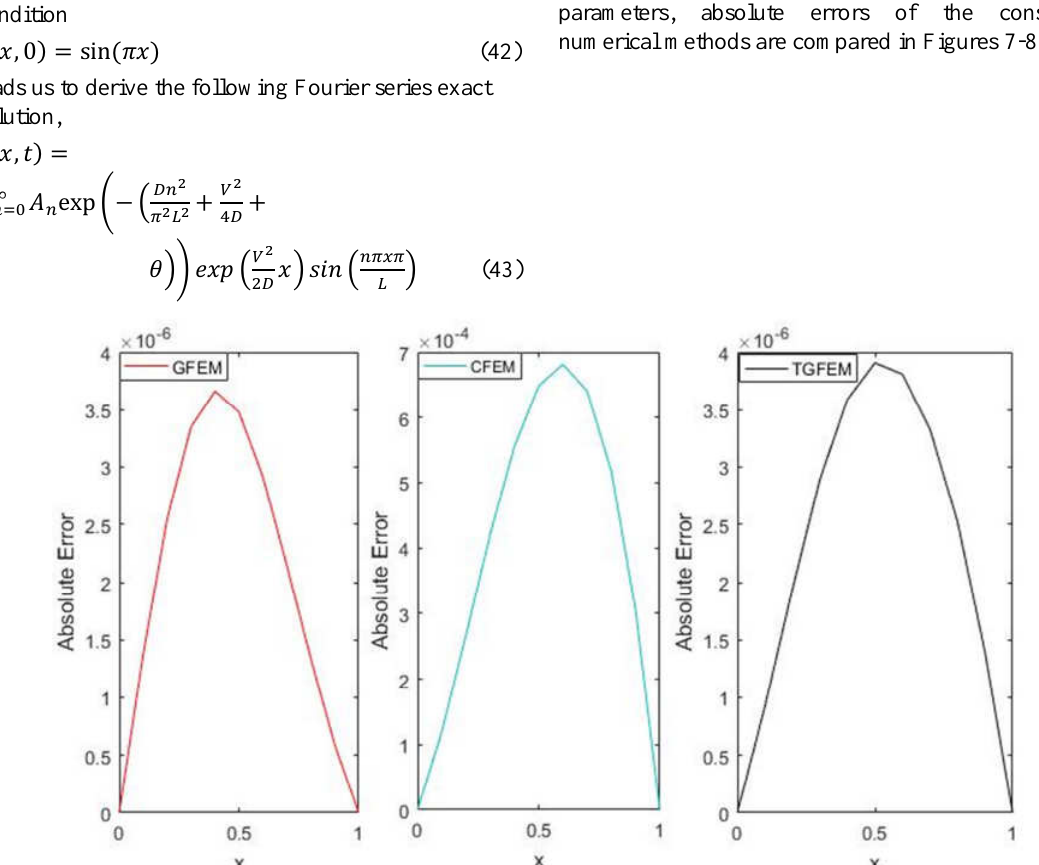
Figure 7 . Comparison of the currently suggested methods in terms of the absolute errors for (cid:14) (cid:2) 0.1 , (cid:10) (cid:2) 0.05,(cid:13)(cid:14) (cid:2) 0.001 ,